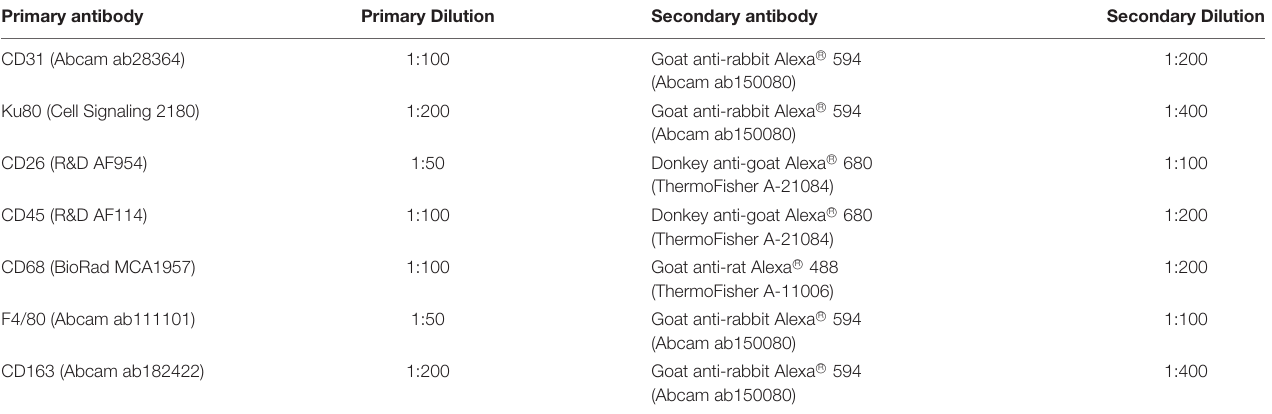
TABLE 2 | Primary and secondary antibodies and dilutions used for immunostaining in the in vivo study. Primary antibody Primary Dilution Secondary